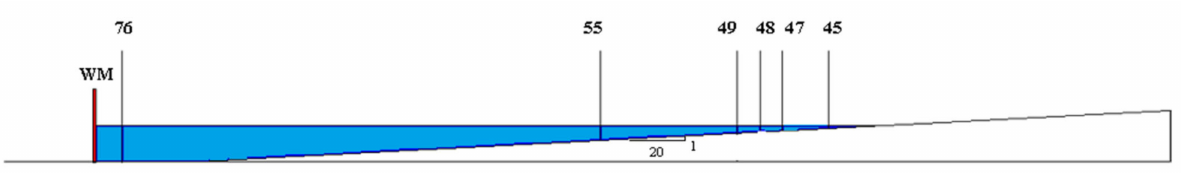
Figure 7. Diagram of the channel with the location of the six investigated sections (From: De Padova et al.